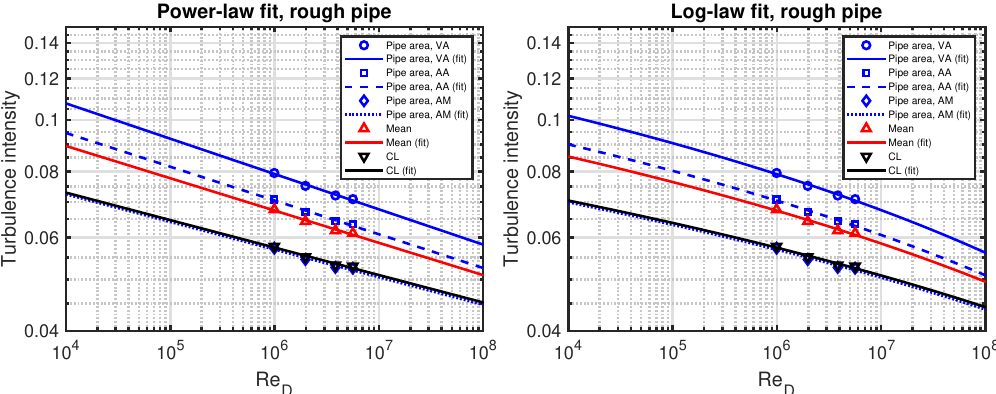
Figure 5. Rough pipe turbulence intensity as a function of Re D , left: Power-law fit, right: Log-law